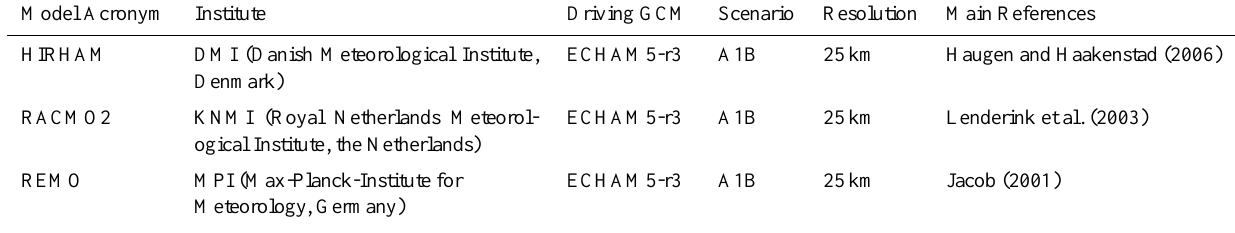
Table 1. The Regional Climate Models used in the study (Acronyms, Institute of origin, Spatial resolution, Emission scenarios, Main references).